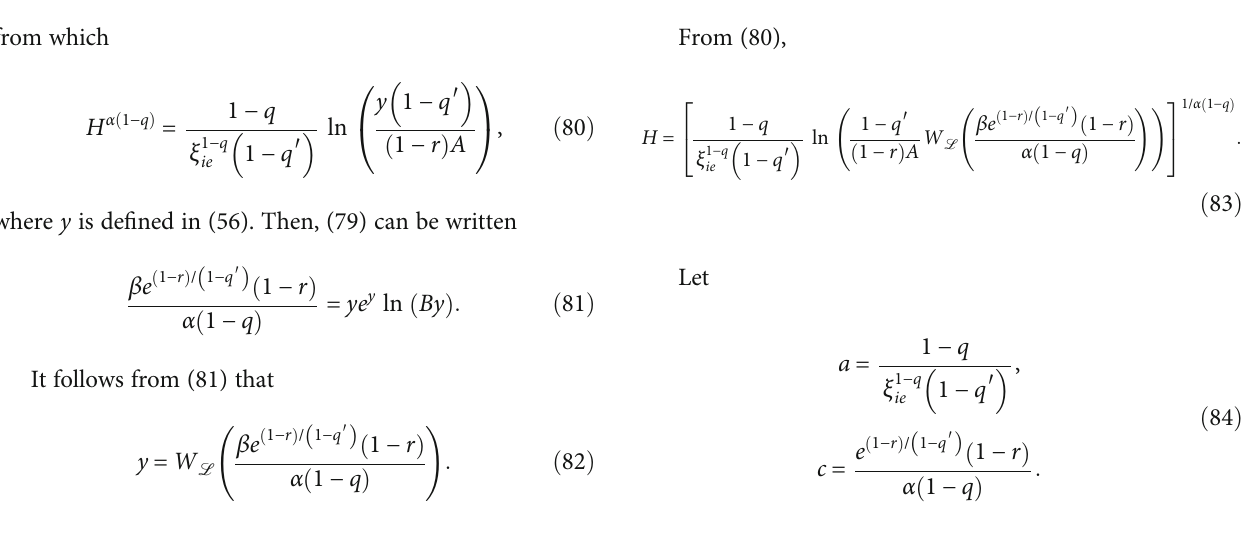
Figure 2: (a) Graph of C when q ′ , r vary and q = 0 : 4 , T = 2 , V = 3 , m = 2 , and h = D = N = k = A = 1 . (b) Graph of C V r = 0 : 6 , T = 3 , V = 4 , m = 2 , h = 1 , D = 1 , and N = k = A = 1